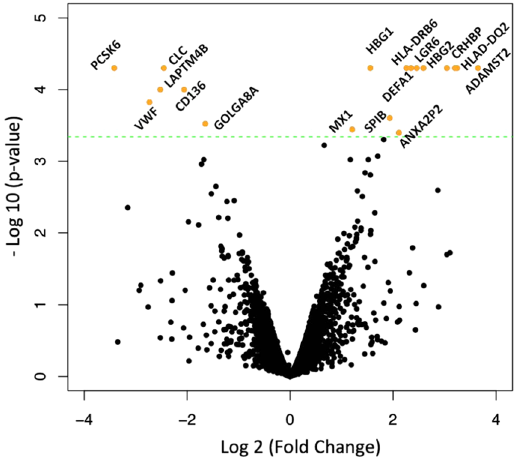
Figure 4. Differential mRNA transcriptome gene expression analysis comparing AML cases with medium and no EBV miRNA expression. Volcano plot showed differential expression between samples above 10 CPMs of EBV reads (n = 12) and those lacking viral miRNA and EBER expression (and n = 14). Genes increasing in EBV positive AML show a fold change increase (right side of the volcano plot) and those decreasing show a reduction in fold change (to the left side of the volcano plot). Genes which were colored orange posses q-values (false discovery rate) below 0.1 (Supplementary Table